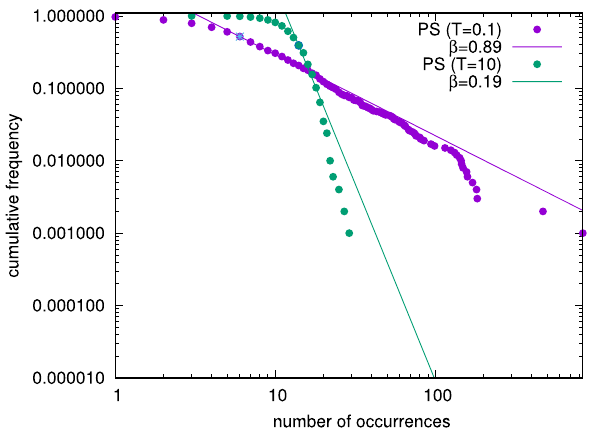
Fig. 2 Scale-free structure of PS formulas with low T = 0.1 and high T = 10 , generated with estimated values of